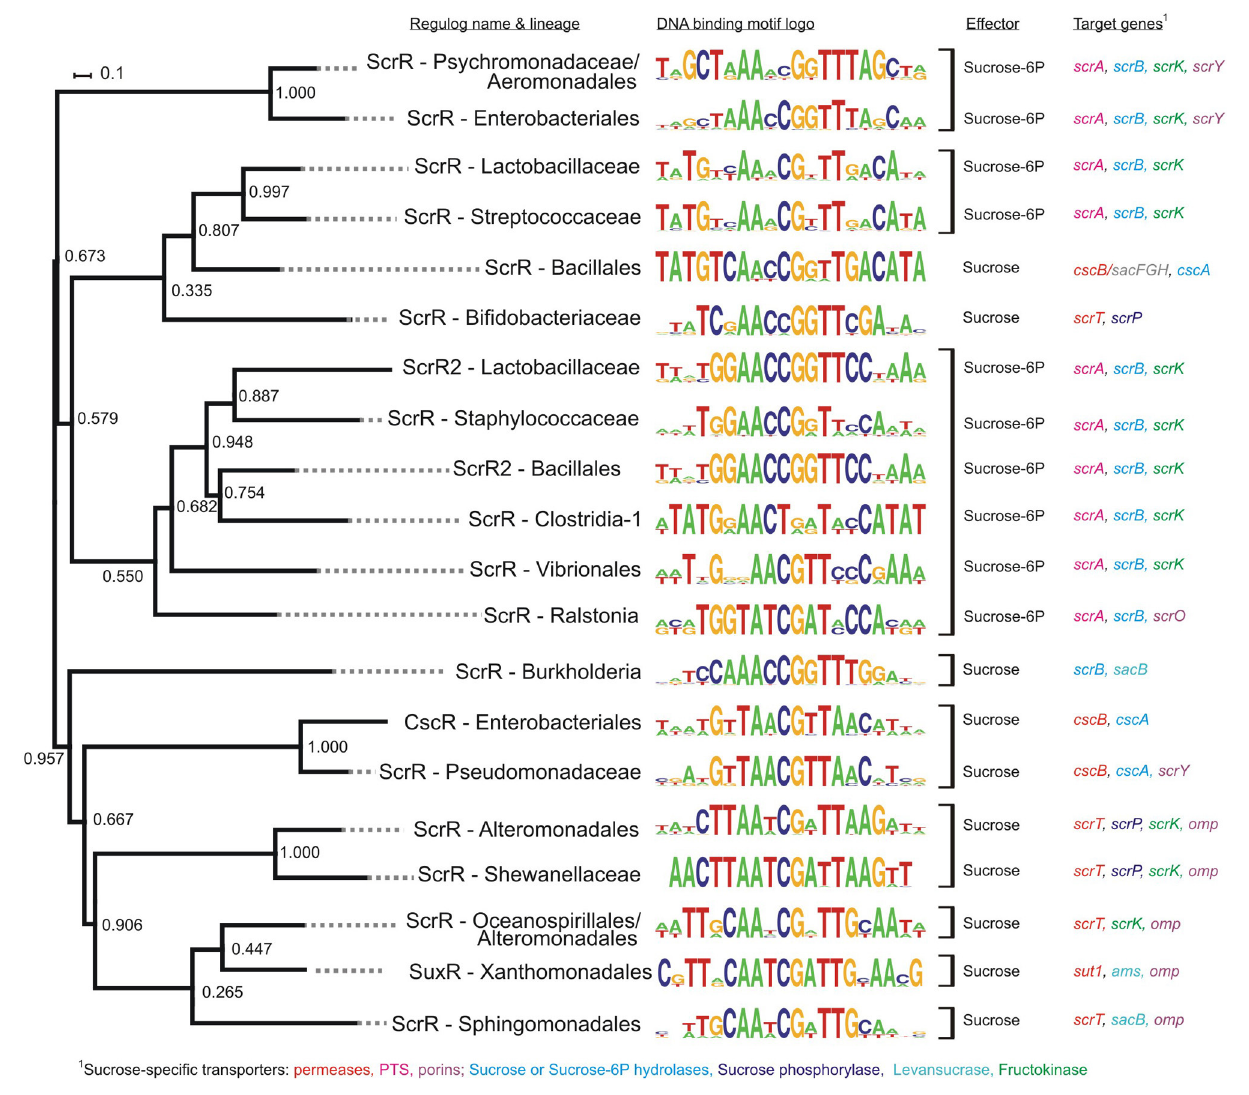
FIGURE 5 | Phylogenetic tree, binding site logos, effectors, and regulon content for regulators of sucrose utilization. Orthologous groups of TFs are shown by square